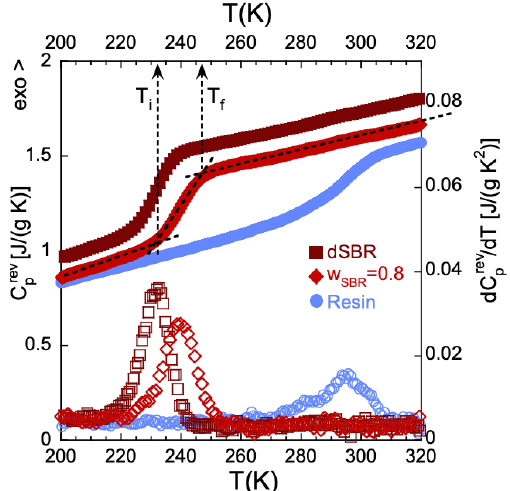
Fig. 1. Results obtained by modulated DSC on the pure components and the blend with 0.80 dSBR weight fraction: reversible part of the specific heat (filled symbols) and its temperature derivative (sign changed, empty symbols). Dotted arrows show, for the blend case, the usual construction to determine the initial and final glass-transition temperature values.